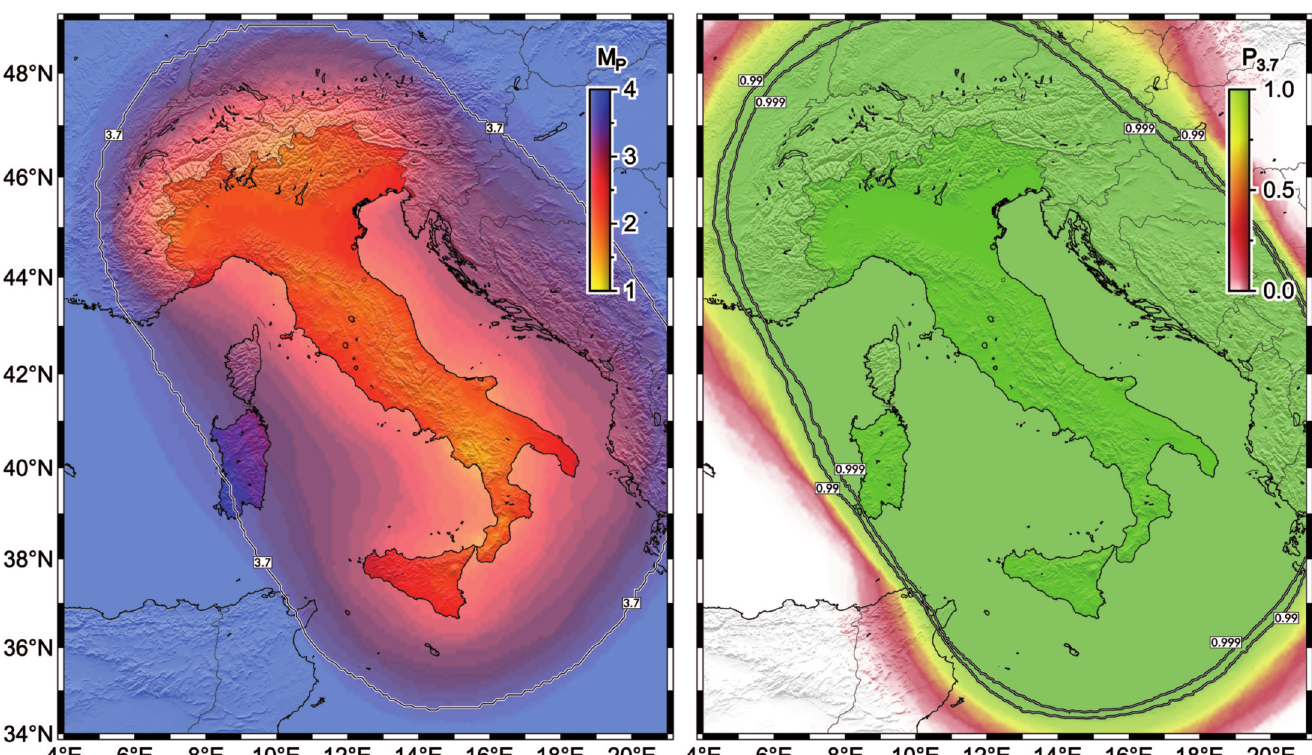
Figure 1. (Left) Probabilistic magnitude of completeness, M , at the P = 0.999 level and at a depth level of 30 km for the INGV network at June 1, 2007. The P E white-framed line indicates the M = 3.7 contour. (Right) Probability of detection for magnitude M = 3.7 events. The probabilities are computed for a depth P level 30 km given the station configuration of June 1, 2007. The two black-framed lines represent the contour levels for detection probabilities of P and P = 0.999 ( P ). Note that the contour of M = 3.7 at the P = 0.999 level does not fully match the contour of P ≡ P 3.7 3.7 E|M=3.7 P E -values are estimated as discrete values in 0.1 steps unlike the discrepancy between the two lines originate from the way the contours are computed. The M P P -values. The contour of the latter is computed by interpolating the P E E